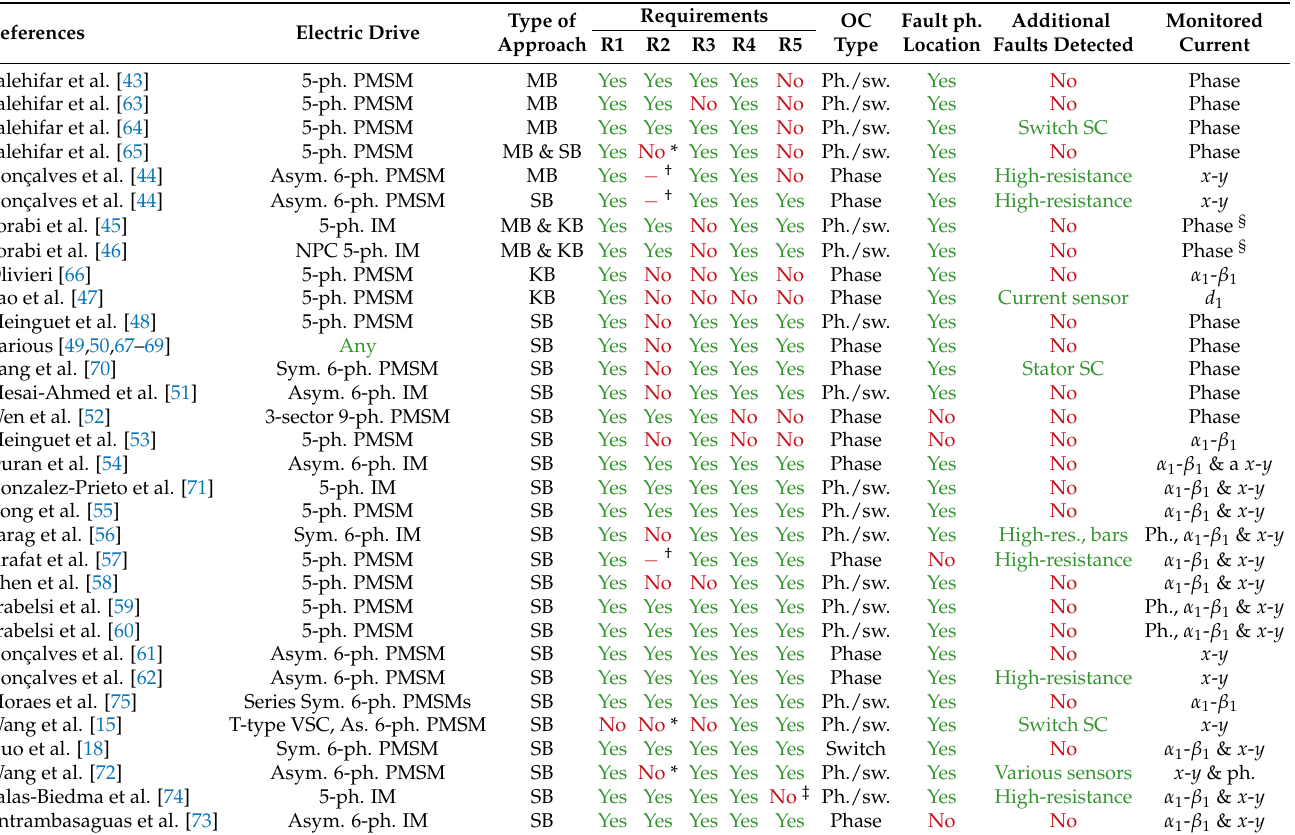
Table 2. Methods for detecting phase/switch OC faults (Section 2) in multiphase applications in the